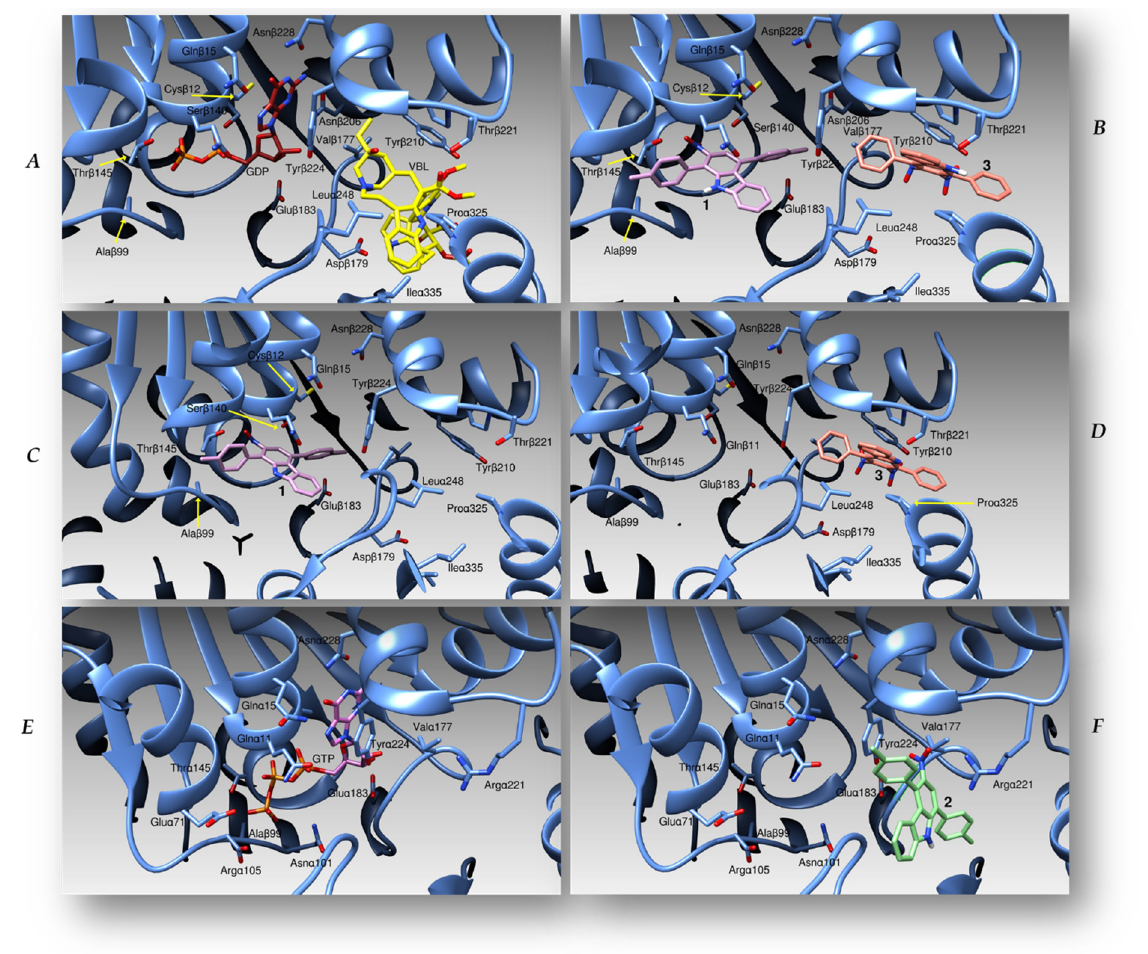
Figure 3. ( A ) A cartoon representation of the tubulin (cyan ribbons) interface between subunits beta and alpha, with vinblastine (VLB, yellow sticks) and guanosyndiphosphate (GDP, red sticks) reported. ( B ) Binding modes of molecules 1 (purple sticks) and 3 (pink) to the beta-alpha interface of tubulin, in the same three-dimensional orientation as ( A ). ( C , D ) The position of compounds 1 (purple) and 3 (pink), respectively, within the same binding site. ( E ) The crystallographic structure of a guanosyntriphosphate (GTP) molecule (drawn in purple) bound to the alpha–beta interface of the protein. ( F ) The pose of compound 2 (green sticks) within the same binding site. We showed and labelled the residues involved in the interactions of the three molecules in the tubulin quaternary structure.